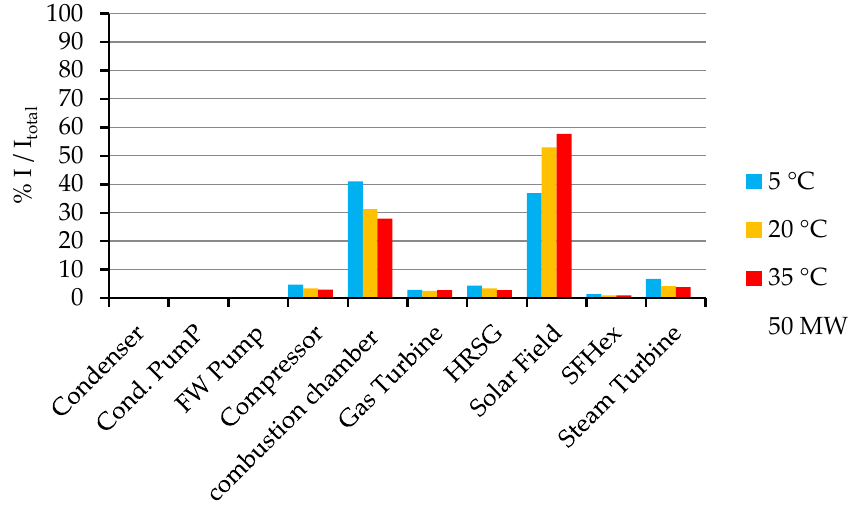
Figure 3. Percentage of exergy destruction in each component of the ISCC out of the total exergy destruction of the plant at different ambient temperatures for solar heat input equal to 0 MW.